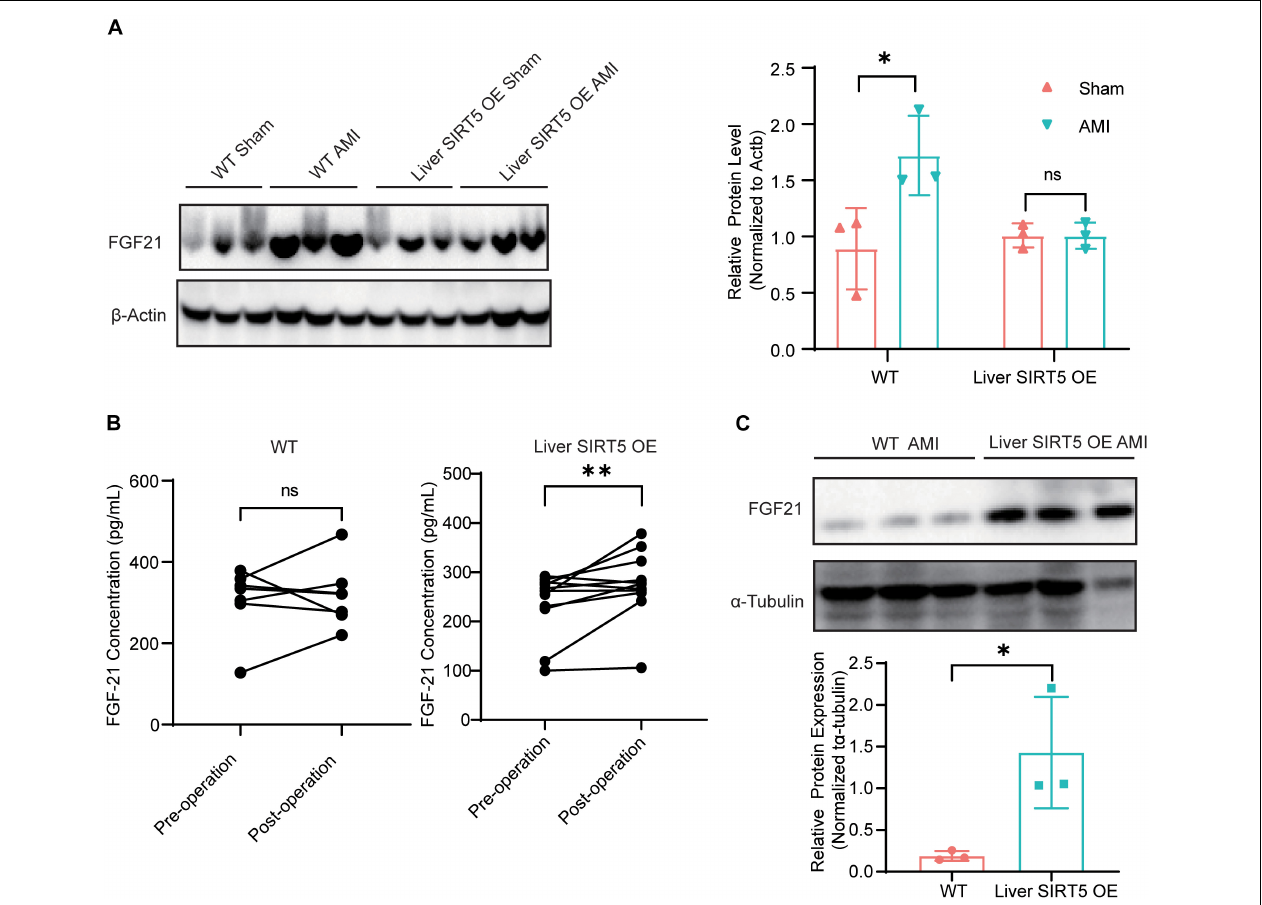
FIGURE 3 | Expression and secretion of FGF21 in mice after AMI. (A) Western blot analysis of hepatic FGF21 in WT or Liver SIRT5 OE 5 days after sham surgery or AMI. Expression levels of FGF21 were normalized to β -tubulin ( n = 3). ∗ p < 0.05 comparing with sham surgery ( n = 3). (B) Comparation of serum FGF21 level in mice before and after AMI ( n = 5). ** p < 0.01. (C) Western blot analysis of cardiac FGF21 in WT or Liver SIRT5 OE 5 days after sham surgery or AMI. Expression levels of FGF21 were normalized to β -tubulin ( n = 3). ∗ p <